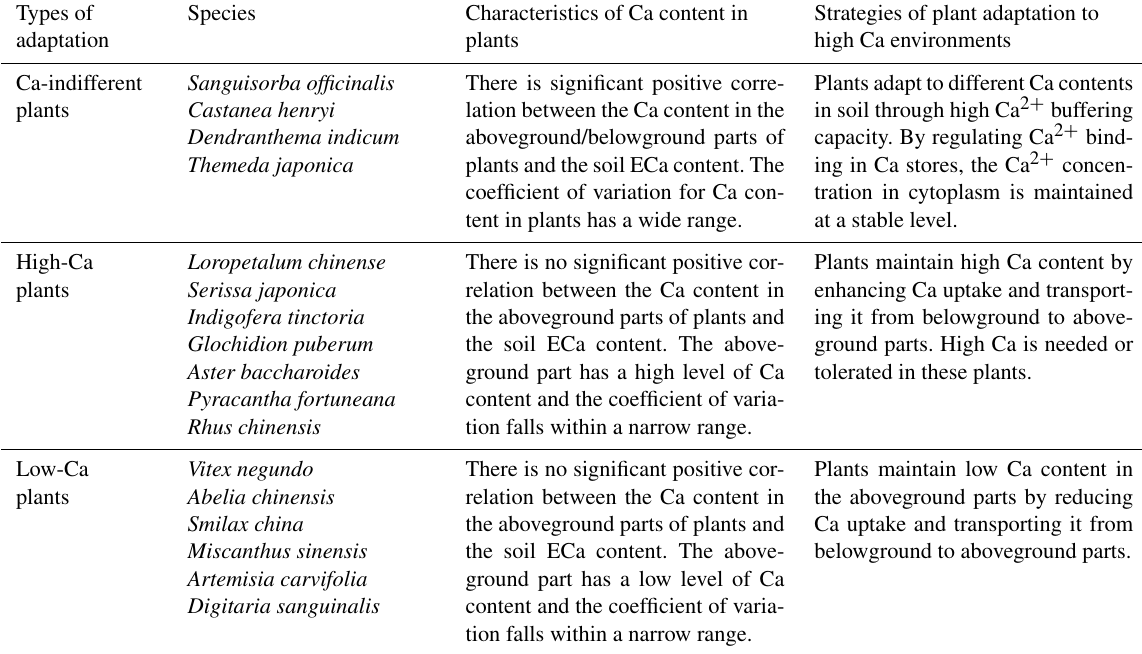
Table 5. Adaptation of plants to high Ca environments in rocky desertification areas. Types